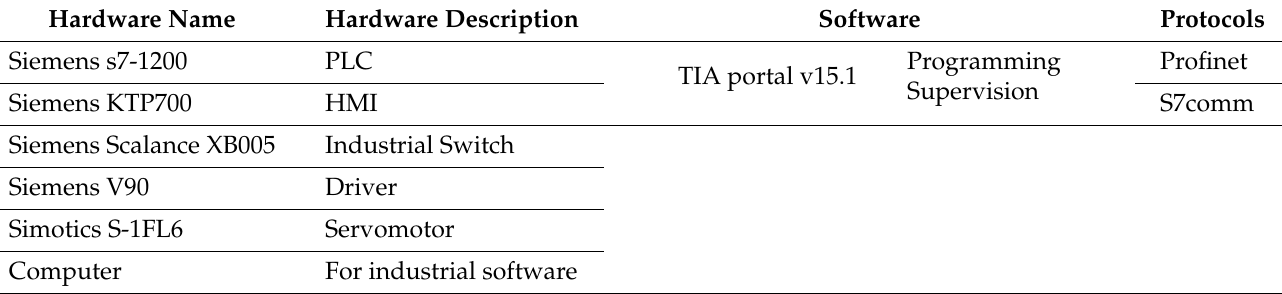
Table 3. Components of industrial motor control system